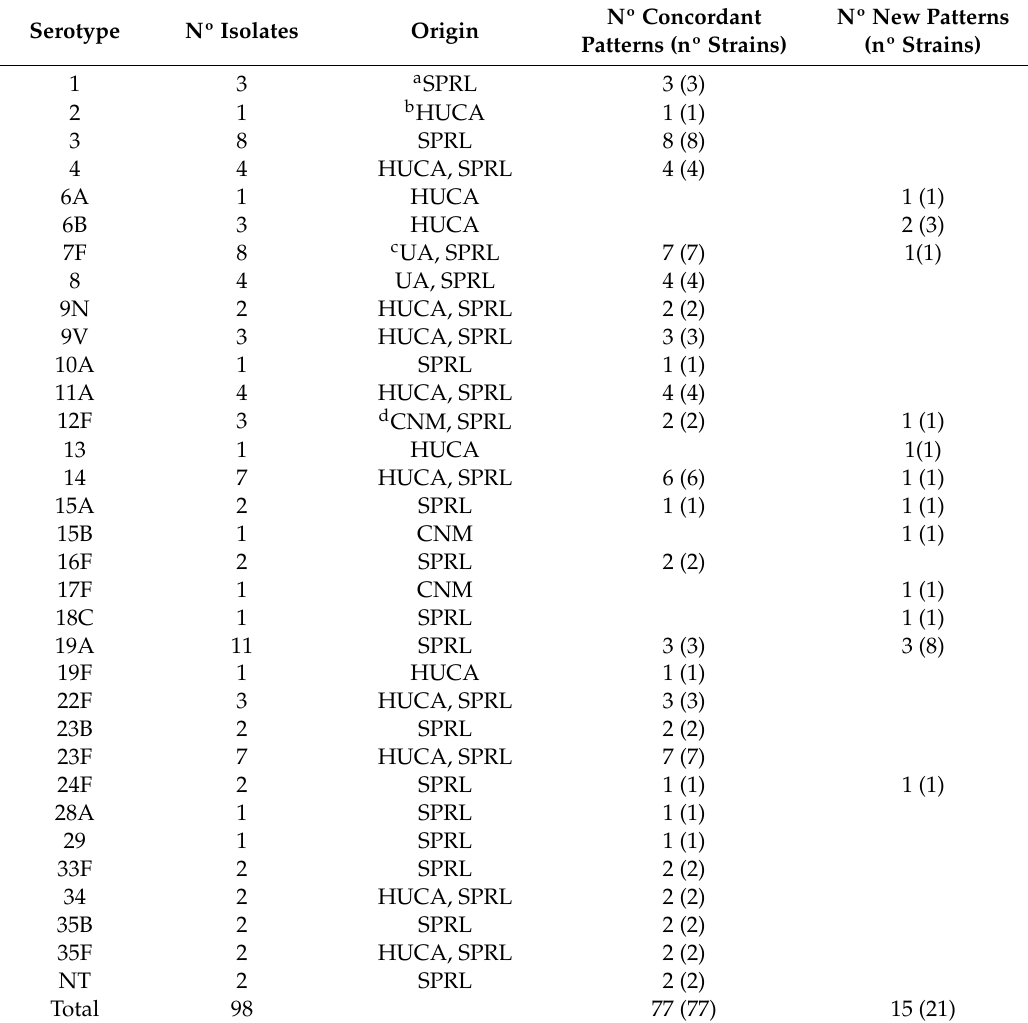
Table 2. Summary of PCR-RFLP analysis of clinical